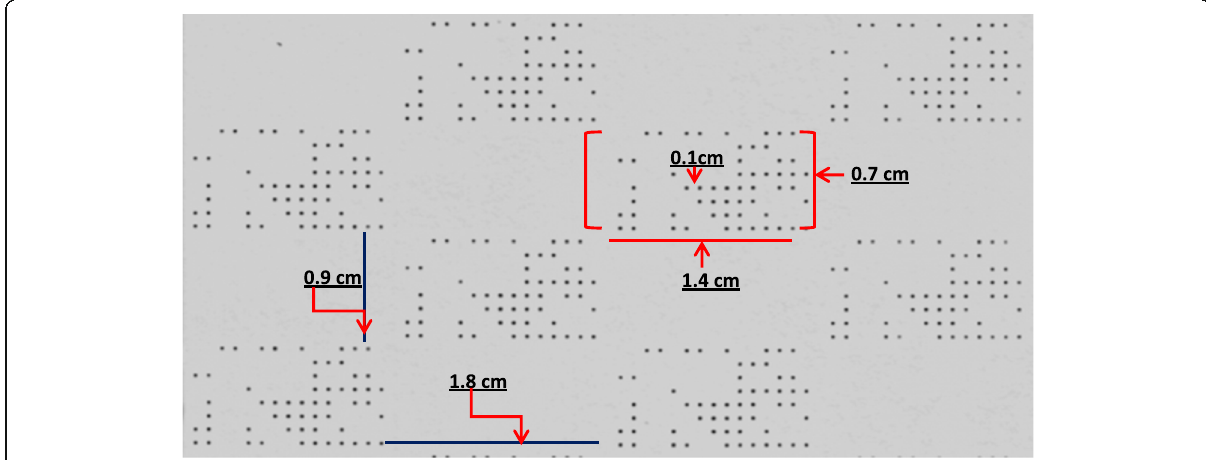
Fig. 12 The visualizations of all distances measured in the grayscale mode for the coded dots matrix embedded in a color laser printout of Xerox®